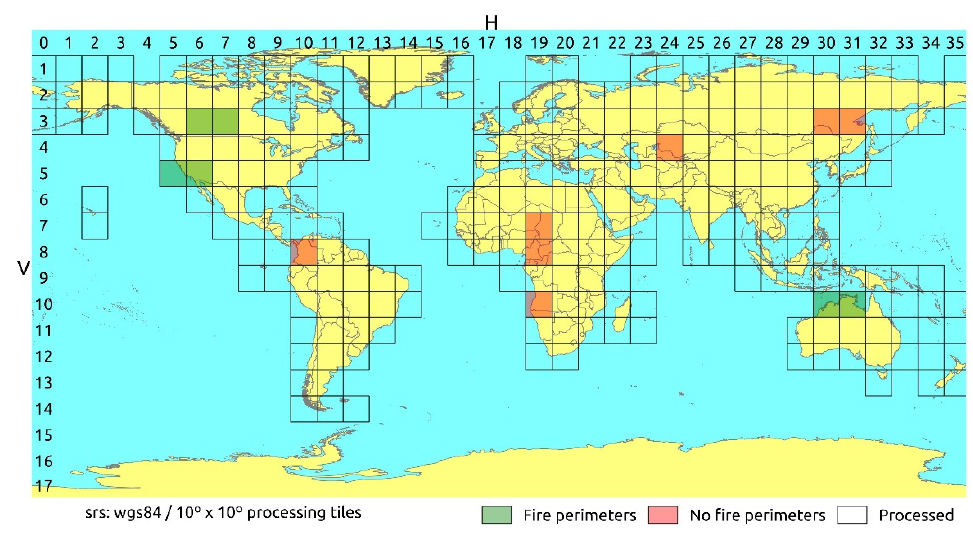
Figure 2. The 10 × 10-degree tiles used for the processing of the OLCI global BA product. A total of 273 tiles were processed, of which 13 were used to adapt the algorithm (red and green tiles).